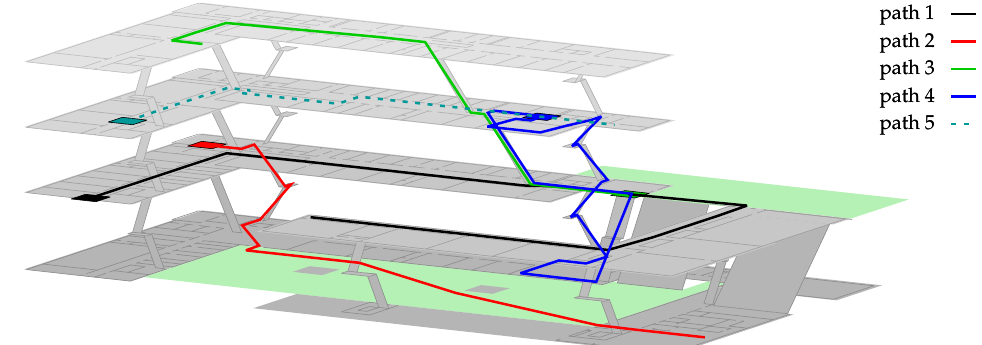
Figure 7. Overview of all conducted paths, each starting at the denoted rectangle. Outdoor areas are marked in green. The length of the paths is as follows: Path 1: 207m, Path 2: 138m, Path 3: 86m, Path 4: 140m, and Path 5: 97m.